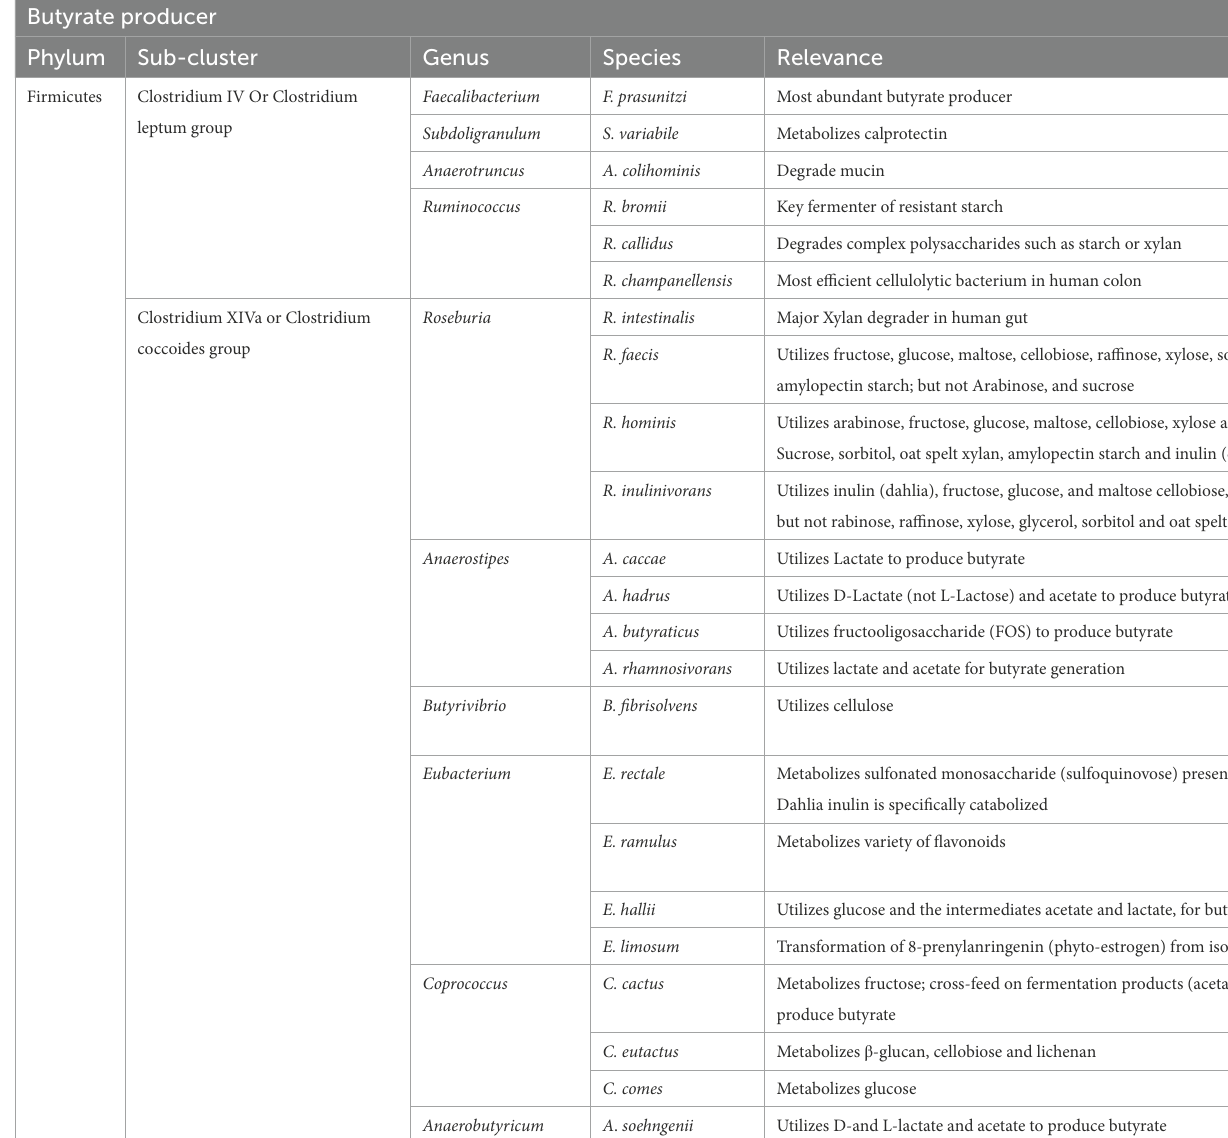
TABLE 1 Major butyrate producers in the human gut and their